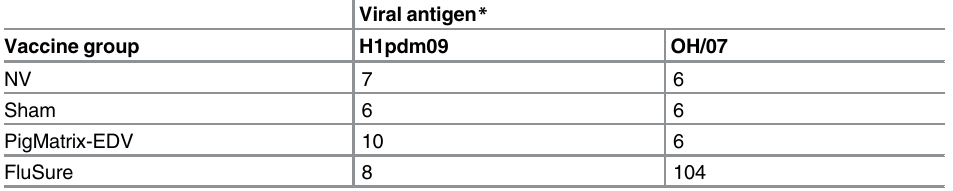
Table 2. Geometric mean reciprocal titers of HI antibodies to different virus in sera collected at 42